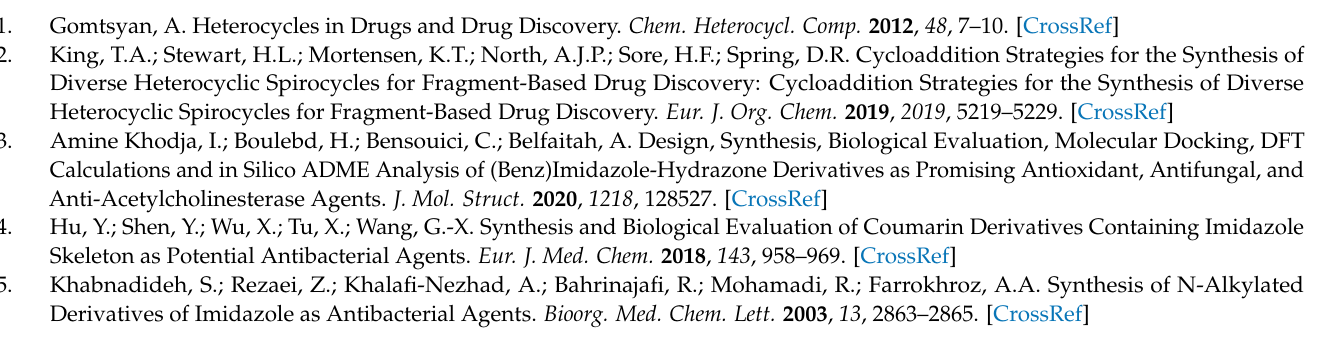
compound 17 at 101 MHz (DMSO- d 6 ), Figure S33: 1 H NMR of compound 18 at 400 MHz (DMSO- d 6 ), Figure S34: 13 C NMR of compound 18 at 101 MHz (DMSO- d 6 ), Figure S35: 1 H NMR of compound 19 at 400 MHz (DMSO- d 6 ), Figure S36: 13 C NMR of compound 19 at 101 MHz (DMSO- d 6 ), Figure S37: 1 H NMR of compound 20 at 400 MHz (DMSO- d 13 C NMR of compound 20 at 101 MHz 6 ), Figure S38: (DMSO- d 6 ), Figure S39: 1 H NMR of compound 21 at 400 MHz (DMSO- d 6 ), Figure S40: 13 C NMR of compound 21 at 101 MHz (DMSO- d 6 ), Figure S41: 1 H NMR of compound 22 at 400 MHz (DMSO- d 6 ), Figure S42: 13 C NMR of compound 22 at 101 MHz (DMSO- d 6 ), Figure S43: 1 H NMR of compound 23 at 400 MHz (DMSO- d 6 ), Figure S44: 13 C NMR of compound 23 at 101 MHz (DMSO- d 6 ), Figure S45: 1 H NMR of compound 25 at 400 MHz (DMSO- d 13 C NMR of compound 25 at 101 MHz 6 ), Figure S46: (DMSO- d 6 ), Figure S47: 1 H NMR of compound 26 at 400 MHz (DMSO- d 6 ), Figure S48: 13 C NMR of compound 26 at 101 MHz (DMSO- d 6 ), Figure S49: 1 H NMR of compound 27 at 400 MHz (DMSO- d 6 ), Figure S50: 13 C NMR of compound 27 at 101 MHz (DMSO- d 6 ), Figure S51: 1 H NMR of compound 28 at 400 MHz (DMSO- d 6 ), Figure S52: 13 C NMR of compound 28 at 101 MHz (DMSO- d 6 ), Figure S53: 1 H NMR of compound 29 at 400 MHz (DMSO- d 13 C NMR of compound 29 at 101 MHz 6 ), Figure S54: (DMSO- d 6 ), Figure S55: 1 H NMR of compound 30 at 400 MHz (DMSO- d 6 ), Figure S56: 13 C NMR of compound 30 at 101 MHz (DMSO- d 6 ), Figure S57: 1 H NMR of compound 31 at 400 MHz (DMSO- d 6 ), Figure S58: 13 C NMR of compound 31 at 101 MHz (DMSO- d 6 ), Figure S59: 1 H NMR of compound 32 at 400 MHz (DMSO- d 6 ), Figure S60: 13 C NMR of compound 32 at 101 MHz (DMSO- d 6 ), Figure S61: 1 H NMR of compound 33 at 400 MHz (DMSO- d 13 C NMR of compound 33 at 101 MHz 6 ), Figure S62: (DMSO- d 6 ), Figure S63: 1 H NMR of compound 34 at 400 MHz (DMSO- d 6 ), Figure S64: 13 C NMR of compound 34 at 101 MHz (DMSO- d 6 ), Figure S65: 1 H NMR of compound 35 at 400 MHz (DMSO- d 6 ), Figure S66: 13 C NMR of compound 35 at 101 MHz (DMSO- d 6 ), Figure S67: 1 H NMR of compound 36 at 400 MHz (DMSO- d 6 ), Figure S68: 13 C NMR of compound 36 at 101 MHz (DMSO- d 6 ), Figure S69: 1 H NMR of compound 37 at 400 MHz (DMSO- d 13 C NMR of compound 37 at 101 MHz 6 ), Figure S70: (DMSO- d 6 ), Figure S71: 1 H NMR of compound 38 at 400 MHz (DMSO- d 6 ), Figure S72: 13 C NMR of compound 38 at 101 MHz (DMSO- d 6 ), Figure S73: 1 H NMR of compound 39 at 400 MHz (DMSO- d 6 ), Figure S74: 13 C NMR of compound 39 at 101 MHz (DMSO- d 6 ), Figure S75: 1 H NMR of compound 40 at 400 MHz (DMSO- d 6 ), Figure S76: 13 C NMR of compound 40 at 101 MHz (DMSO- d 6 ), Figure S77: 1 H NMR of compound 41 at 400 MHz (DMSO- d 13 C NMR of compound 41 at 101 MHz 6 ), Figure S78: (DMSO- d 6 ), Figure S79: 1 H NMR of compound 42 at 400 MHz (DMSO- d 6 ), Figure S80: 13 C NMR of compound 42 at 101 MHz (DMSO- d 6